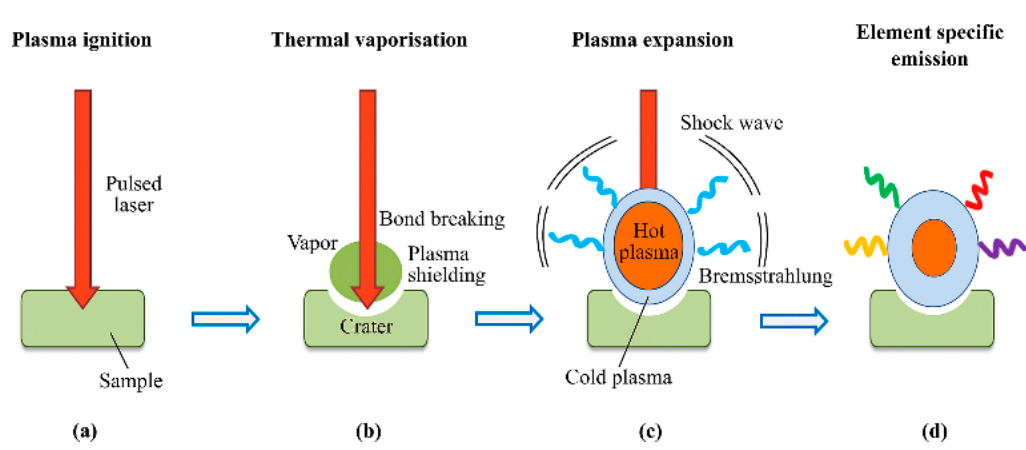
Figure 5. Main steps in the laser pulse/material interaction resulting in the generation of laser induced breakdown spectroscopy (LIBS) emission signals. ( a ) Plasma ignition; ( b ) thermal vaporization; ( c ) plasma expansion; ( d ) element specific emission. Adapted from [92], with permission from © 2017 Elsevier.